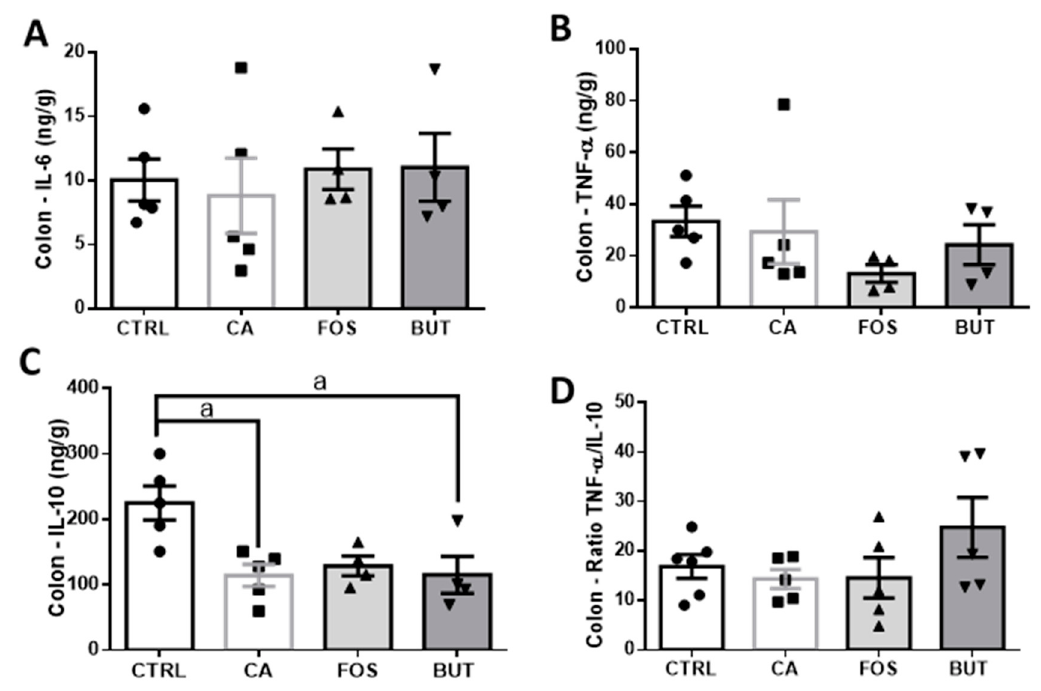
Figure 9. Colon carcinogenesis induction did not promote pro-inflammatory markers, but reduced IL-10 content in the colon: IL-6 ( A ), TNF- α ( B ), IL-10 ( C ), TNF- α /IL-10 ratio ( D ) in colon. Mice were divided into four groups: control group (CTRL— n = 5) fed with chow diet; and colon carcinogenesis-induced groups fed either with chow diet (CA— n = 5), TB-supplemented diet (BUT— n = 4), or with FOS-supplemented diet (FOS— n = 4). Colon carcinogenesis was induced chemically by azoxymethane (AOM)/dextran sodium sulphate (DSS). Data are presented as means ± SEM. The groups were compared using one-way ANOVA followed by Bonferroni post hoc tests; for p < 0.05 (a); black circles ( ● ), square ( ∎ ), triangles ( ▲ ), inverted triangles ( ▼ ) represents sample numbers in the corresponding group.